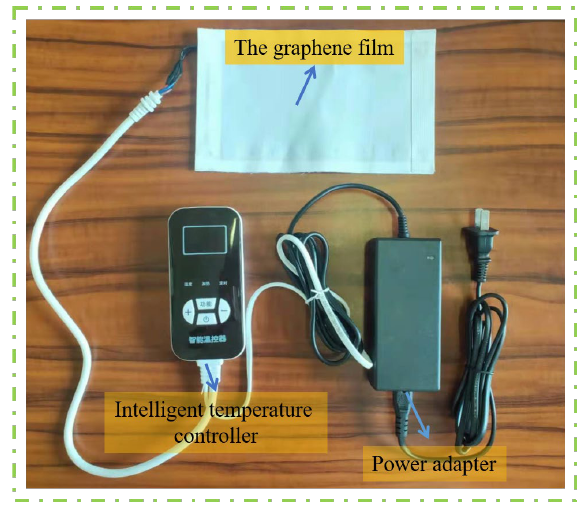
Figure 2. Physical picture of the graphene heating device.